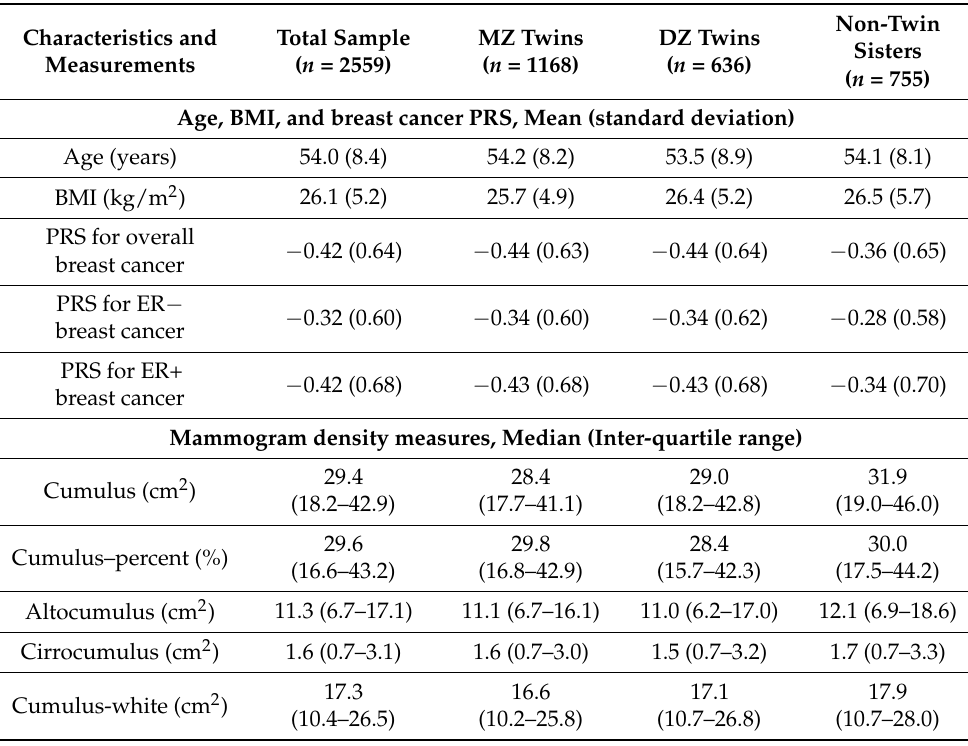
Table 1. Characteristics of the study sample combined, and by categories of twins and